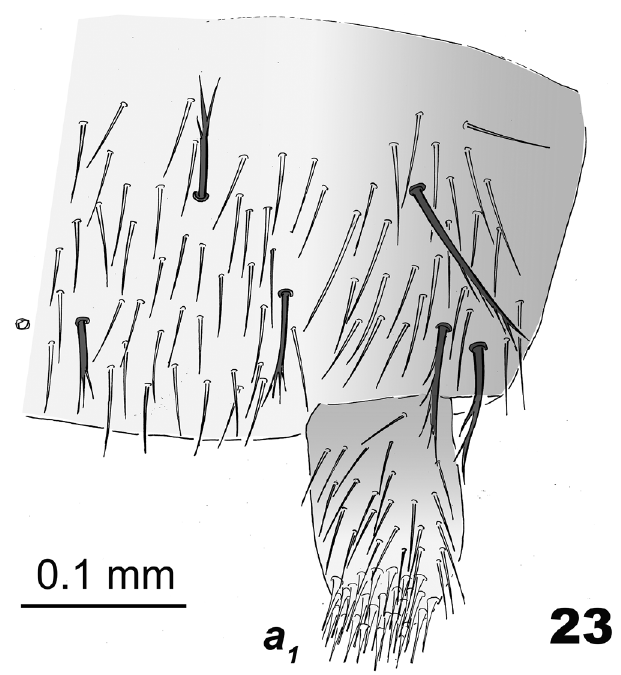
Figure 23. Haplocampa wagnelli Sendra, sp. n. First female urosternite, ♀ paratype, 6 mm.